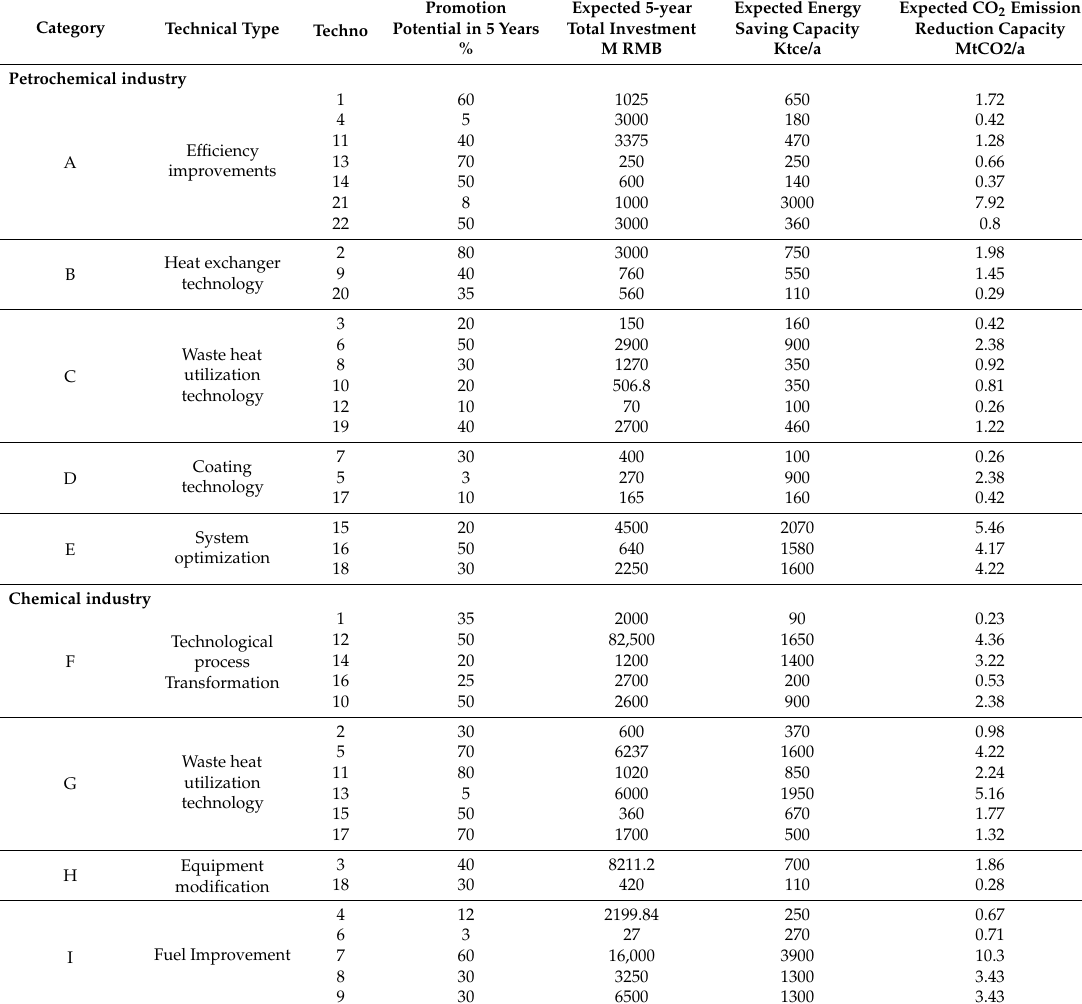
Table 2. Main parameters of mitigation